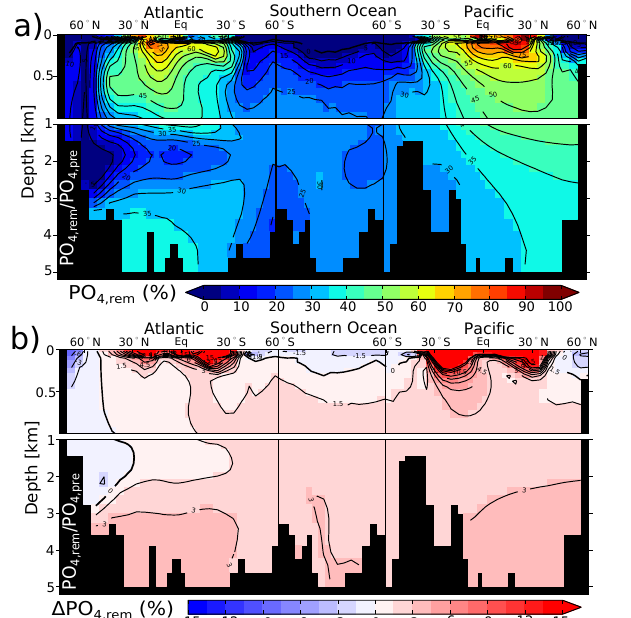
Figure 10. (a) Percentage fraction of remineralised:preformed nu- trients in the control simulation. Remineralised nutrient concentra- tion is estimated as − AOU / 170, where AOU denotes the apparent oxygen utilisation as calculated as O 2 − O 2,sat . (b) Change in this fraction in a POM deepening experiment ( l POM : 250m → 275m) in the open